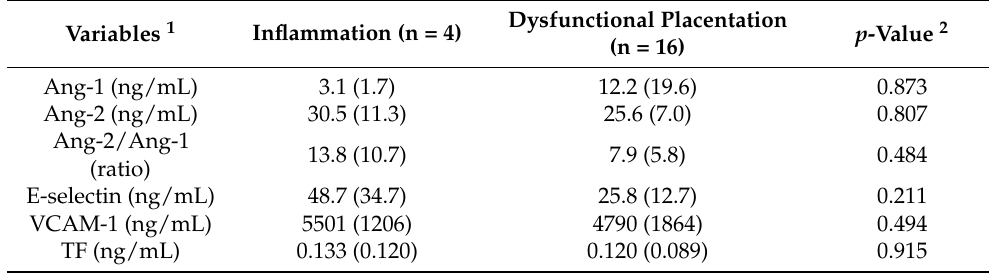
Table 5. Soluble endothelial markers at T1 and maternal endotype in very preterm